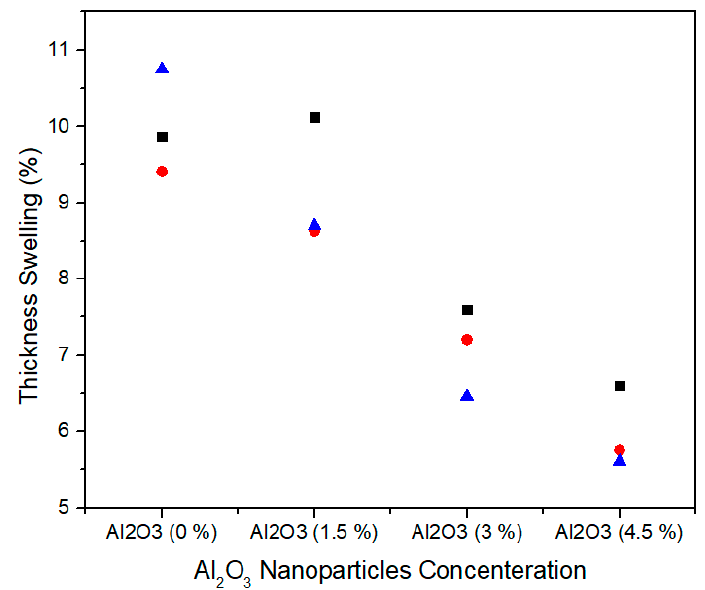
Figure 16. Numerical values of Thickness Swelling of various treatments of Alumina nanoparticles.